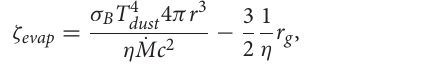
Eddington units. Such a description is only valid when the